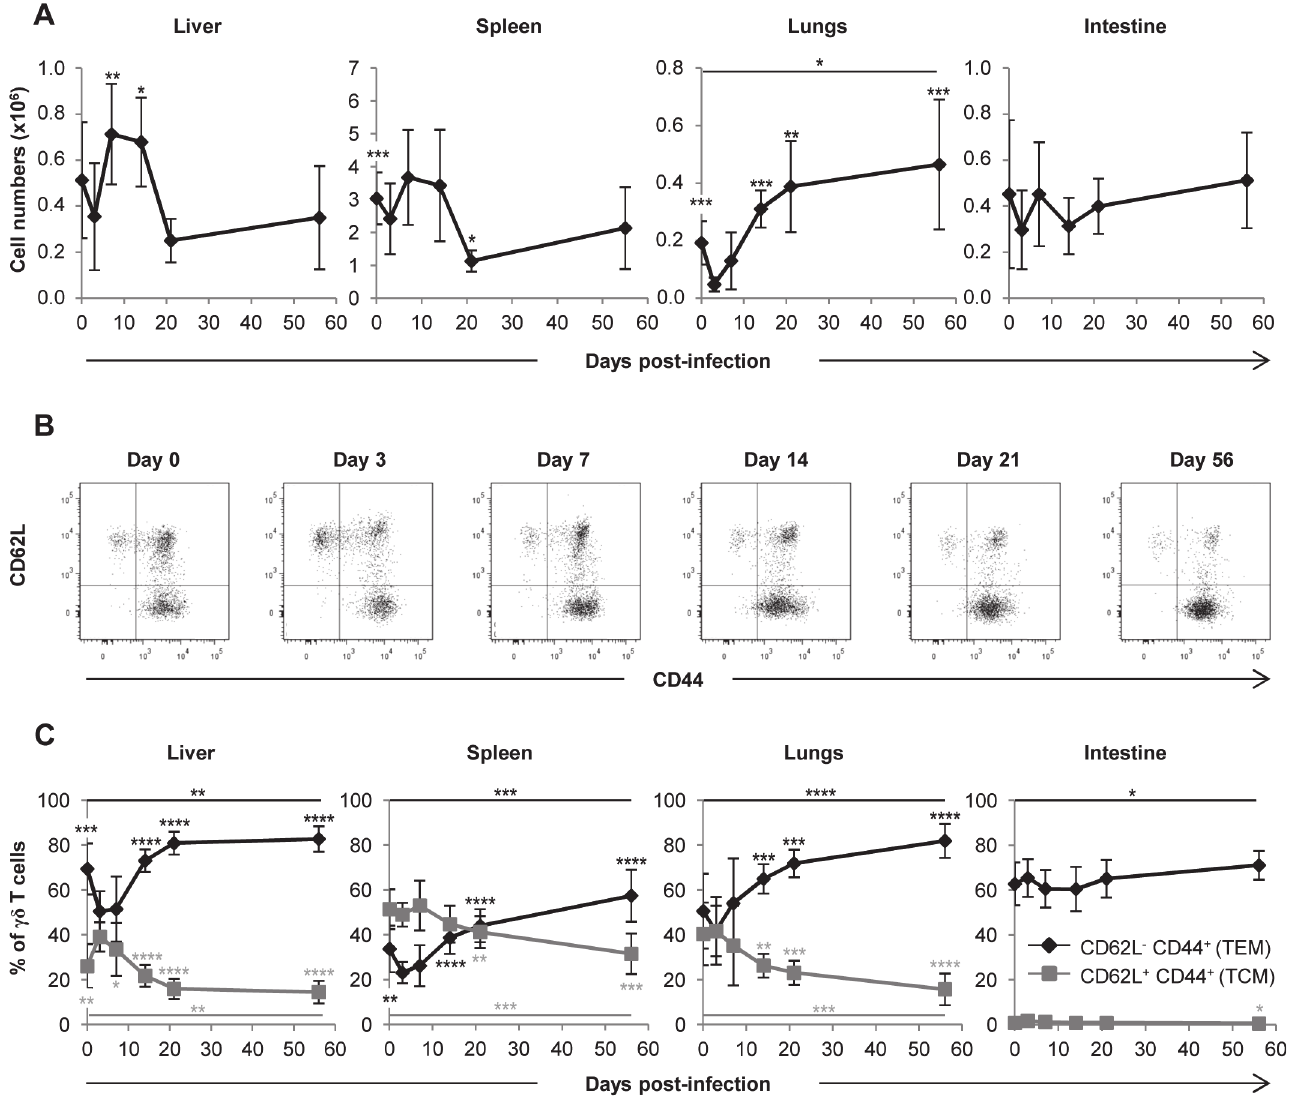
Fig 4. Mobilization of γδ T cells in MCMV-infected organs from TCR α − / − mice. TCR α − / − mice were infected i.p. with 2.10 3 PFU of MCMV. At indicated post-infection days, 5 – 9 mice were sacrificed, immune cells prepared from each organ and γδ T cells stained as shown in S2 Fig. A. Kinetics of absolute γδ T cell numbers determined as described in methods. Presented data are mean ± SEM of 8 – 9 mice from one representative of 2 experiments. B . CD62L and CD44 expression by lymphocytes was evaluated by flow cytometry, with the presented gating strategy (lungs shown as example). C. Longitudinal analysis of γδ T cell phenotype in all organs. Results are pooled from 2 independent experiments representing a total of 13 – 14 mice (means ± SEM). Statistical differences of cell numbers and percentages between day 3 and other time points are shown, as well as statistical differences between days 0 and 56 (solid